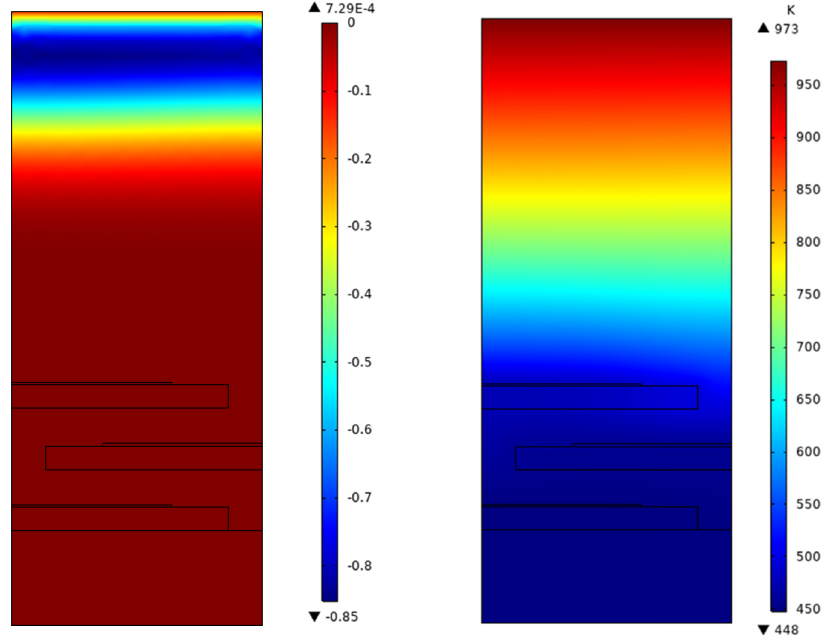
Figure 6. Distribution of reaction rate of water–gas shift in mol/(m 3 · s) and temperature (K) in case C.